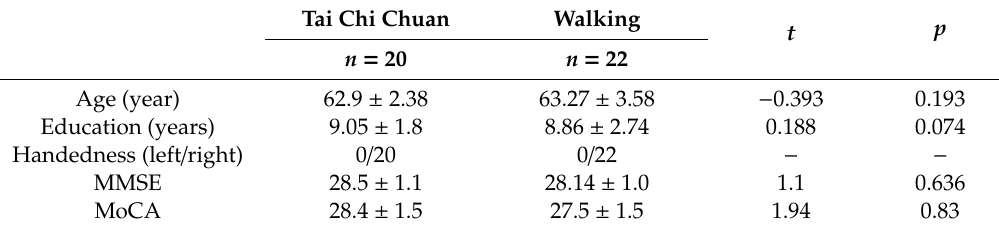
Table 1. Characteristics of study participants.